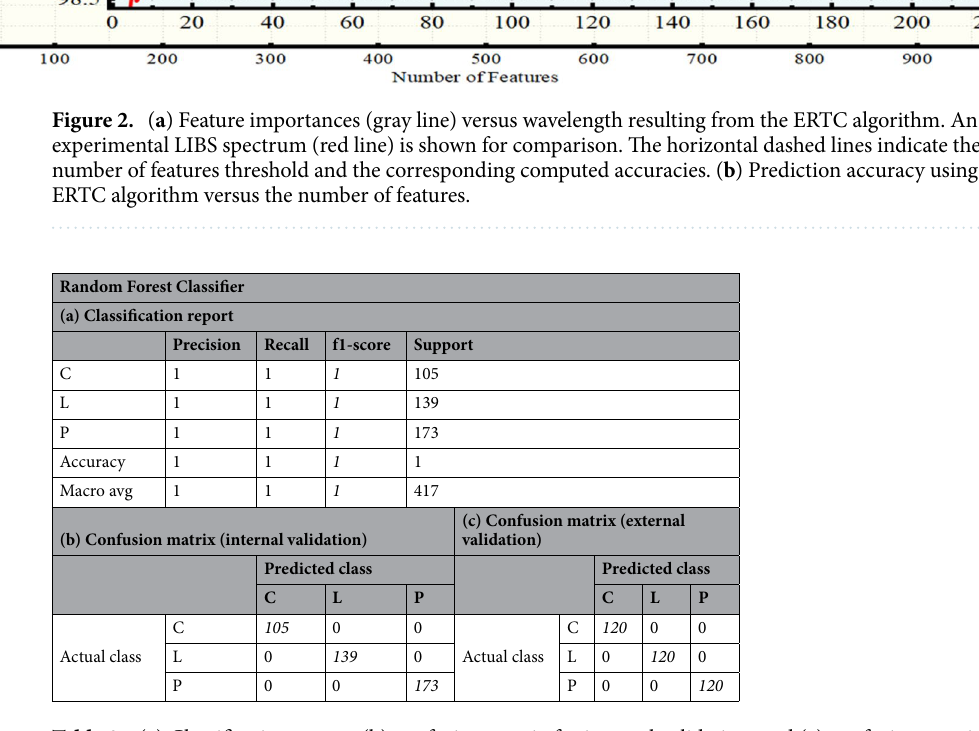
Table 3. (a) Classification report, (b) confusion matrix for internal validation, and (c) confusion matrix for external validation resulting from the RFC algorithm.